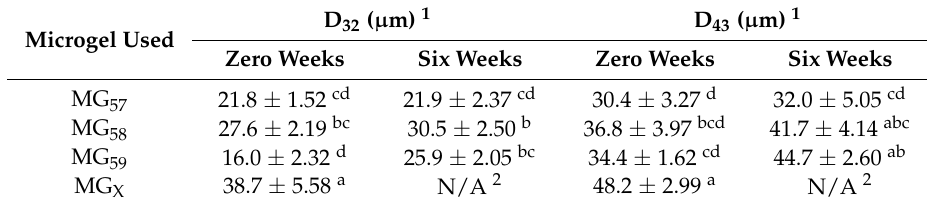
Table 2. Effect of Blg microgel fabrication pH and cross-linking treatment on the moment-based average diameters of limonene/corn oil-in-water emulsions after initial preparation (zero weeks) and after six weeks of